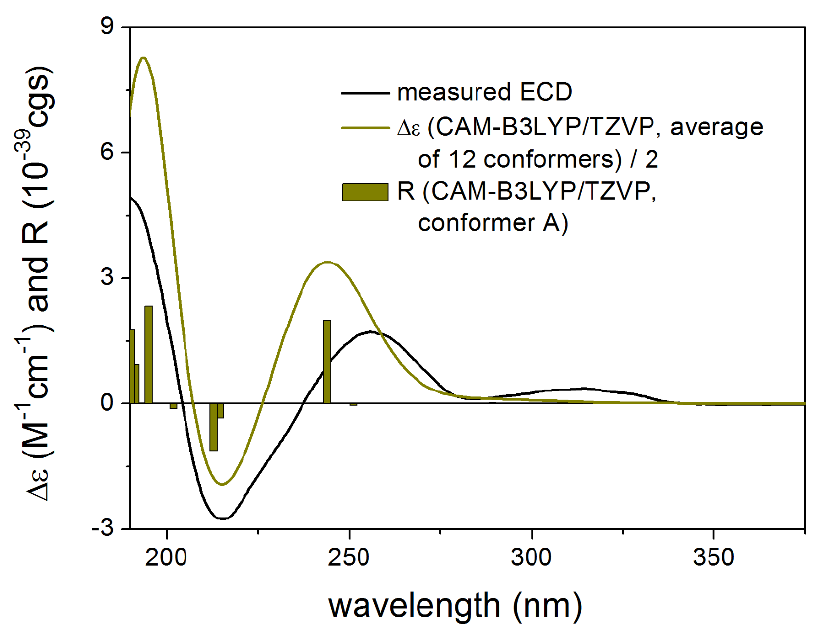
Figure 2. Comparison of the experimental ECD spectrum of 1 measured in MeCN with the CAM-B3LYP/TZVP PCM/MeCN spectrum of (4 R ,6 R ,7 R ,8 S ,9 R ,10 R )- 1 (level of optimization: CAM-B3LYP/TZVP PCM/MeCN). The bars represent the rotational strength values of the lowest energy conformer.